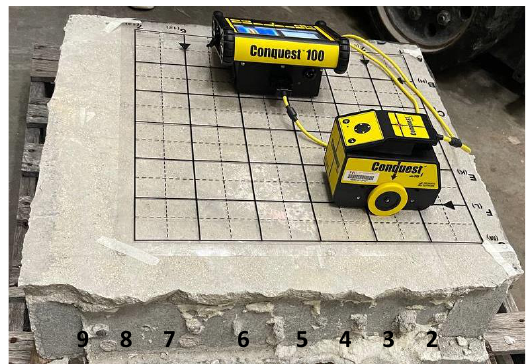
Figure 4. GPR grid scan test setup for Slab L.